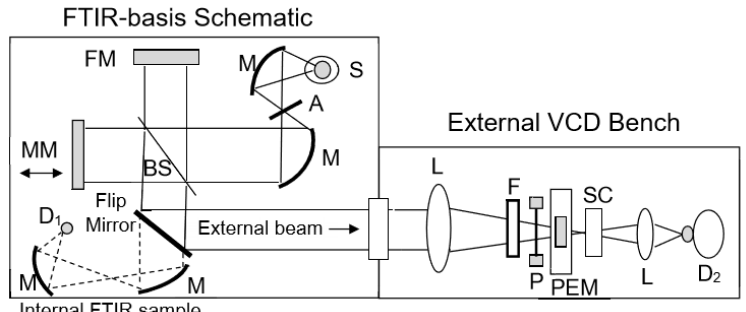
Figure 2. Schematic of the main optical components of a typical FT-VCD instrument constructed by coupling a VCD accessory bench to a commercial FTIR. These include (S) a light source, (M) collimating mirrors with (A) aperture restriction, (FM) a fixed mirror, (MM) a moving mirror, (BS) and a beam splitter, plus normal sampling using separate focusing mirrors and (D 1 ) an internal detector for independent transmission FTIR. A schematic of an external VCD bench includes (L) a sample focusing lens, (F) a filter, (P) a wire gird polarizer, (PEM) a photoelastic modulator, (SC) a sample cell, (L) a detector focusing lens, and (D 2 ) a MCT detector for VCD.